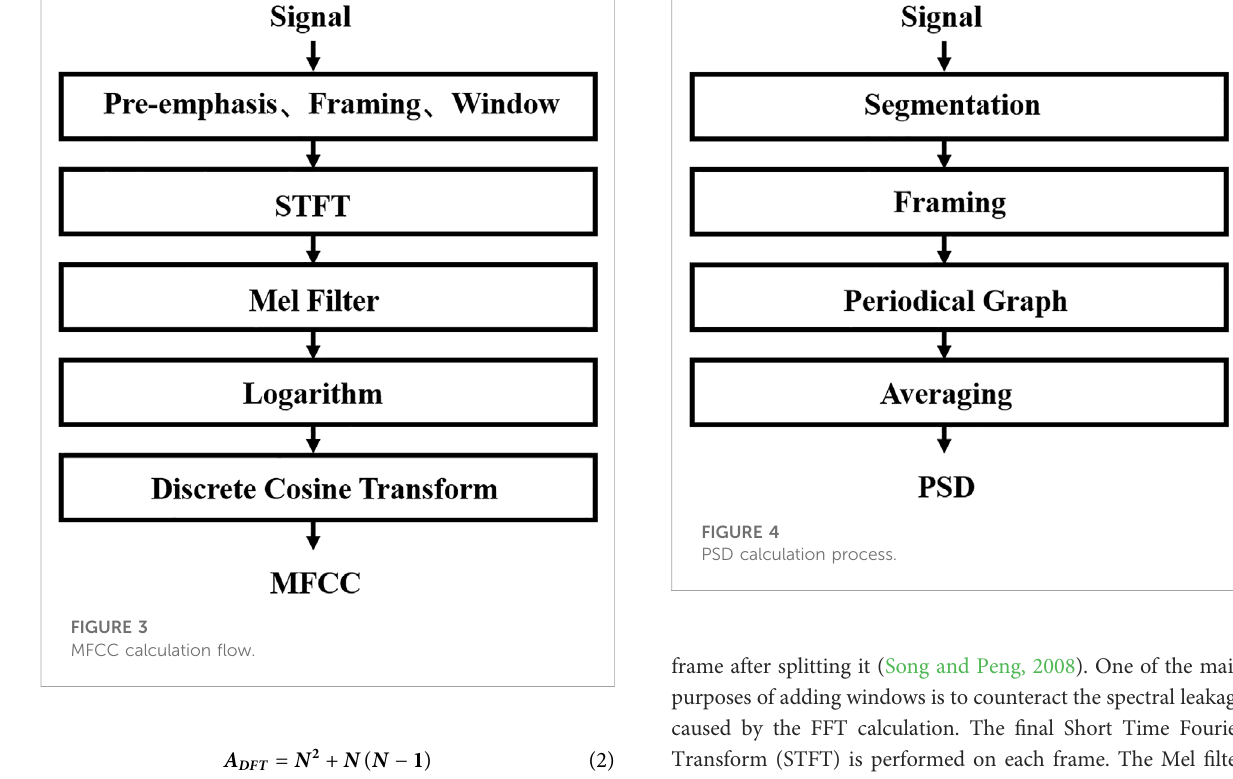
FIGURE 3 MFCC calculation fl ow.